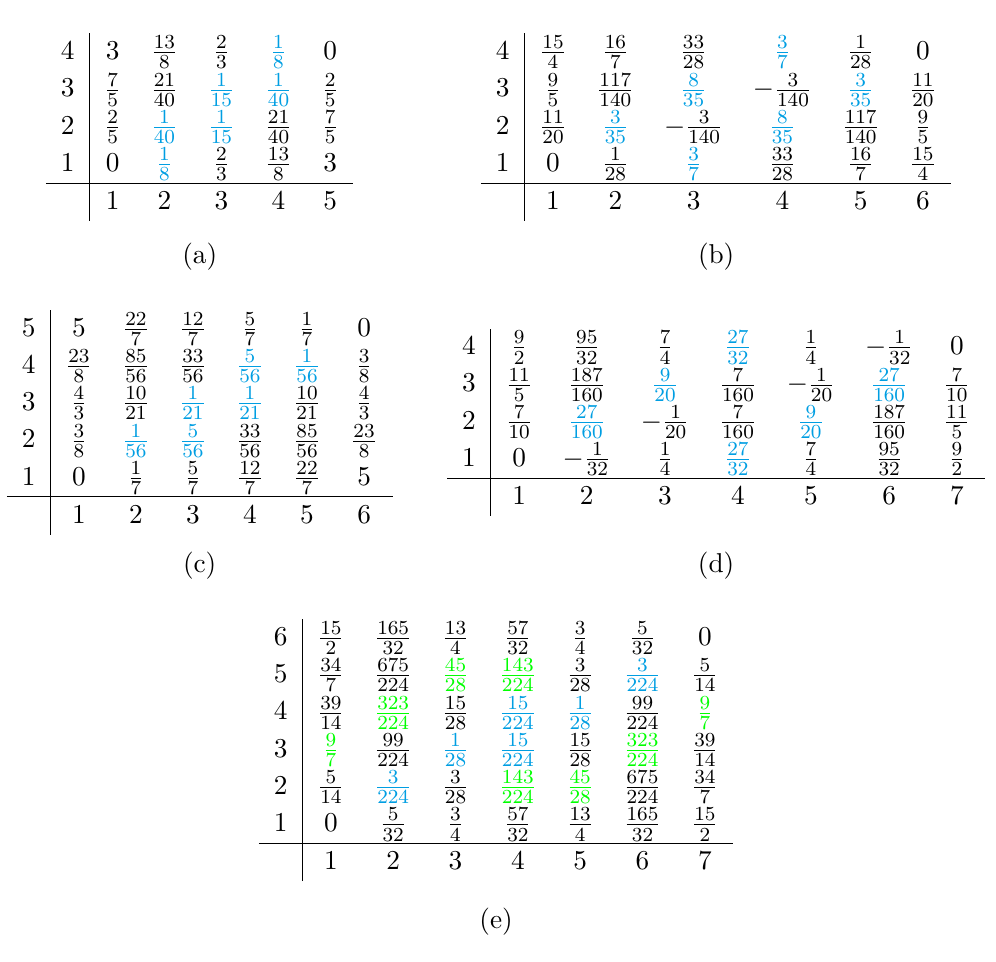
Figure 3. Here we list the first five possible examples of CBs that Γ(3) corresponds to: (a) p 0 = 6 , p = 5 , (b) p 0 = 7 , p = 5 , (c) p 0 = 7 , p = 6 , (d) p 0 = 8 , p = 5 , (e) p 0 = 8 , p = 7 . Those appeared in the CBs are in cyan in the Kac tables. For (e), we also have another combination of CBs in